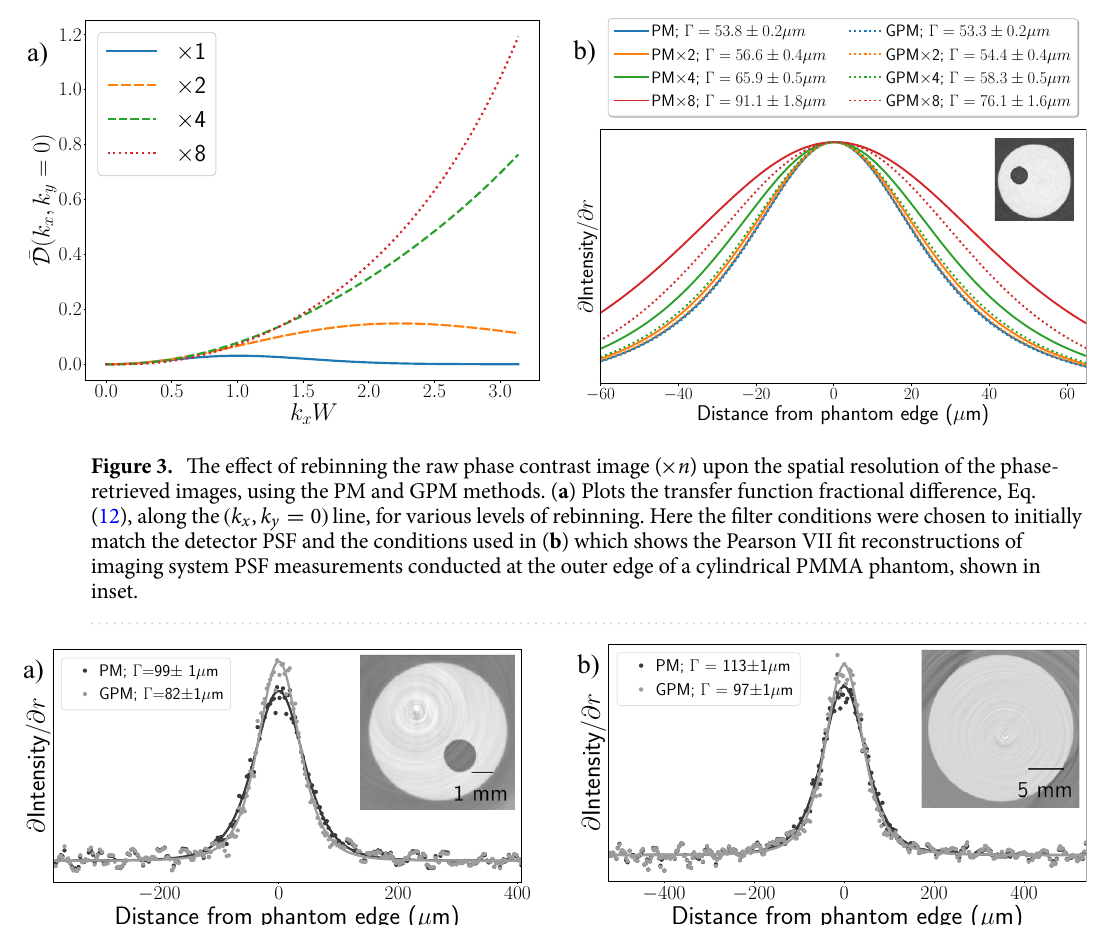
Figure 4. PSFs measured by azimuthally averaging the outer edge PMMA cylinders in CT recorded at 2 m propagation distance with 24 keV beam energy using ( a ) a Advacam Modupix and ( b ) a LAMBDA photon- counting detector. Voxel size = 55 µ m . The PMMA cyclinder used in ( a ) contains an off-centre circular cavity while the cylinder in ( b ) is solid PMMA nearing the detector width in